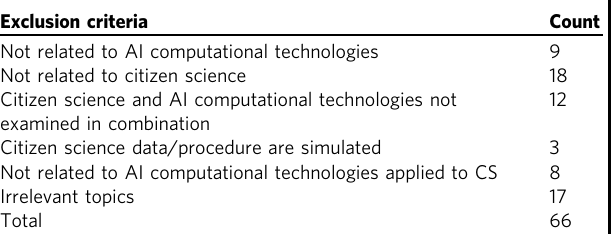
Table 3 Exclusion criteria for procedure 1 and 2 and number of excluded